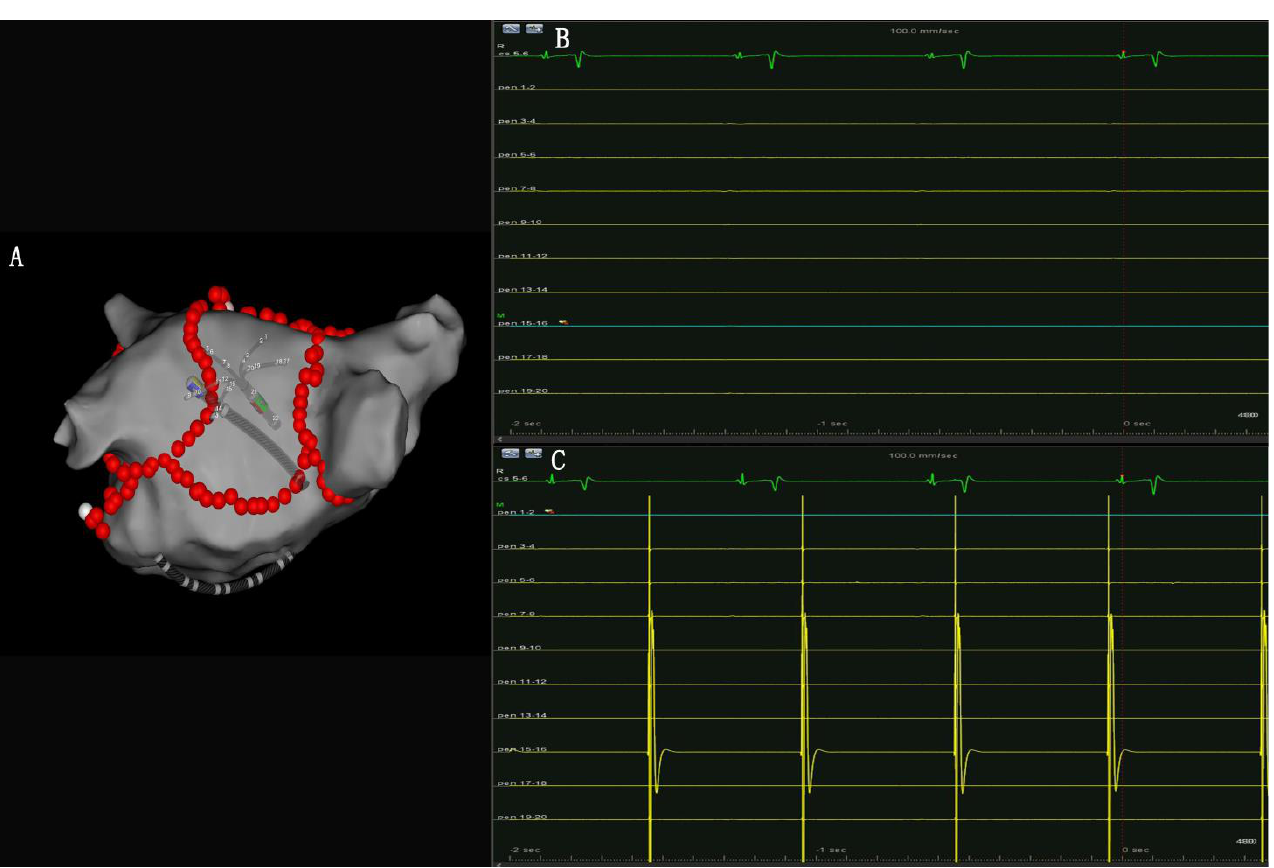
Figure 3. ( A ): Pentaray catheter was placed in LA posterior wall to assess PWI. ( B ): No atrial electrical signal was recorded by Pentaray catheter indicated a successful entry block of LA posterior wall. ( C ): LA posterior wall was paced using Pentaray catheter and failed 1:1 atrial capture was observed, indicating a successful enter block of LA posterior wall.